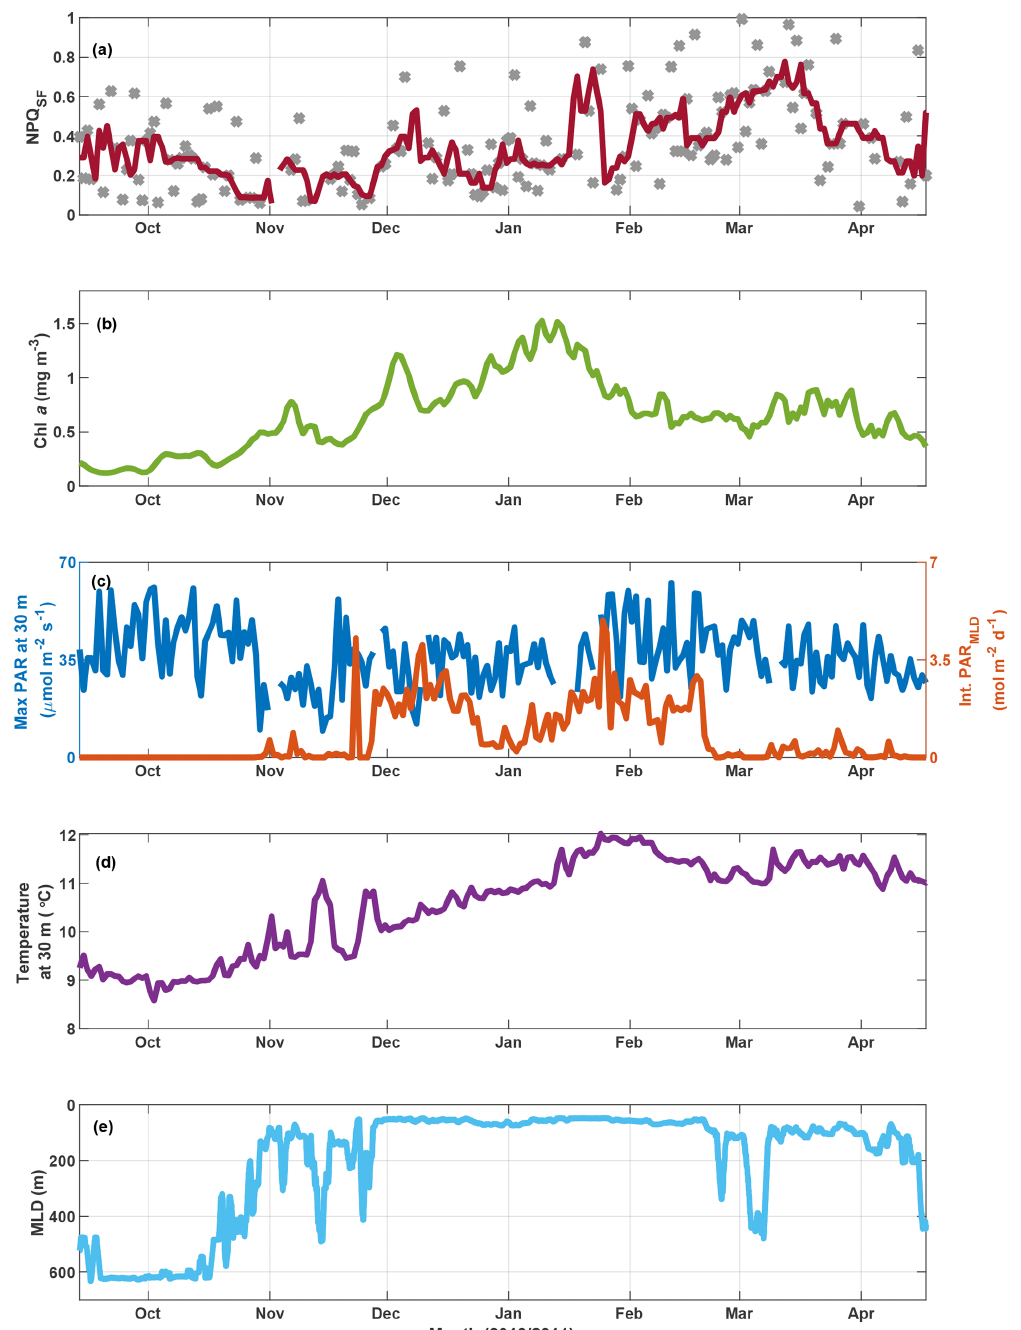
Figure 9. SOTS mooring data for October 2010 to April 2011. Panel (a) shows NPQ SF (see Fig. S11 for a version where NPQ SF is normalized to PAR at F min ), with grey markers indicating daily estimates and the red line a 7d running median. Panel (b) shows a three-point running mean over daily Chl a concentrations estimated based on calibrated fluorescence. Panel (c) shows maximum PAR recorded at 30m for any given day (left axis) and the integrated daily PAR for the mixed layer (right axis), with incident PAR calculated based on latitude, longitude, time of year, and clear-sky conditions; PAR attenuation estimated as a function of Chl a based on Morel et al. (2007); and MLD as in panel (e) . Water temperature at 30m is shown in panel (d) , and the mixed-layer depth is indicated in panel (e) (see Sect. 2.6 for